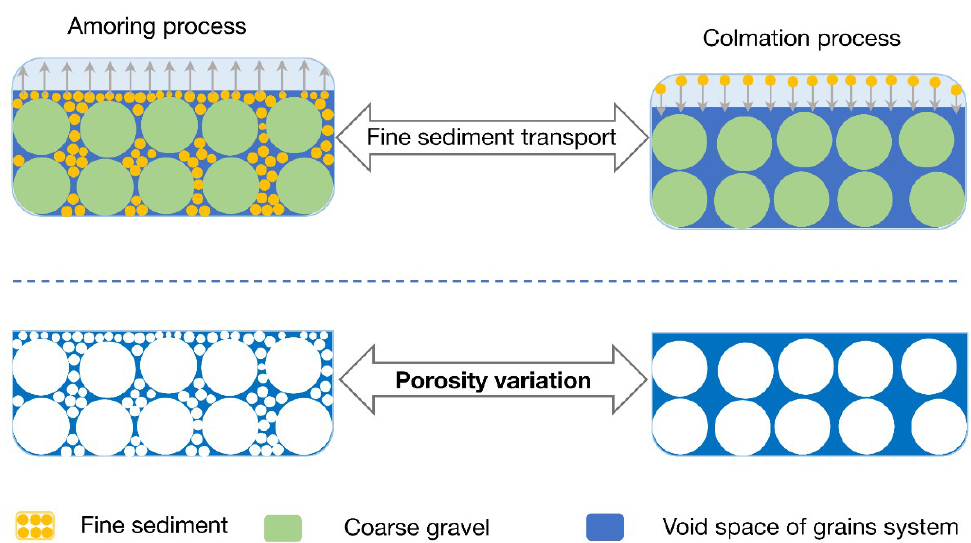
Figure 1. Porosity variation of grain system due to fine grain exchange.